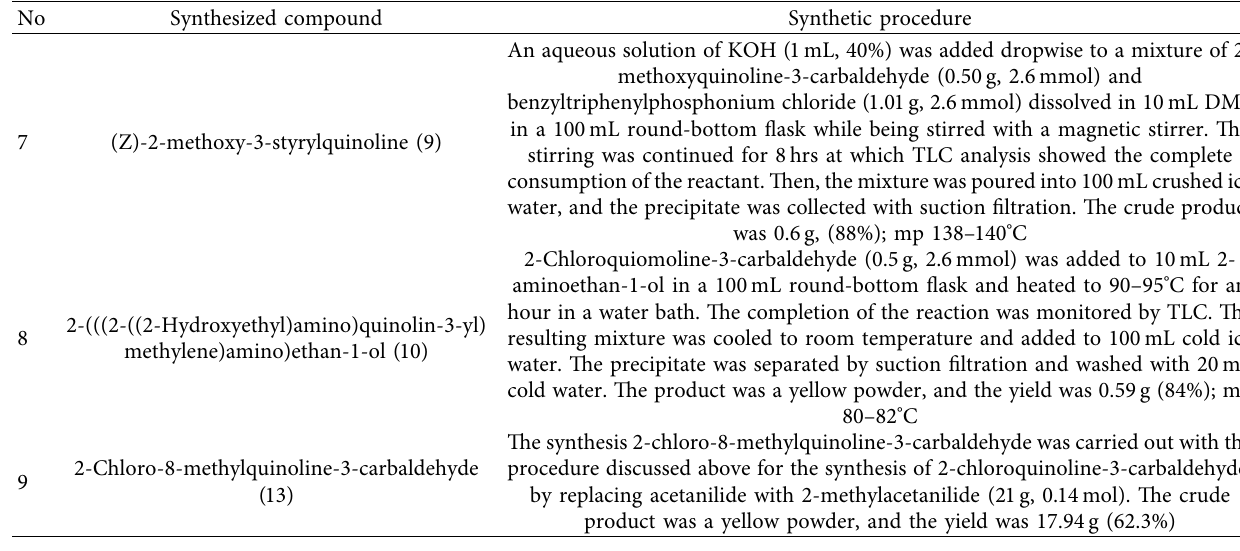
Table 3: Continued table of the synthesized compounds and their synthetic procedure.